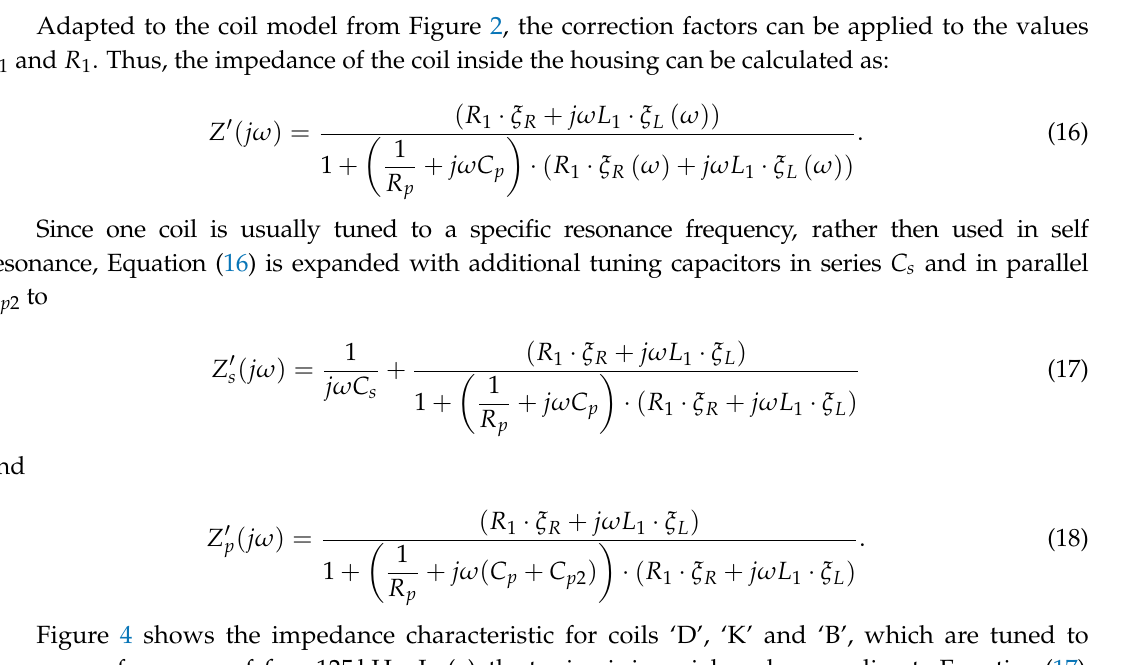
= 0.1mm (see W A (cid:31)